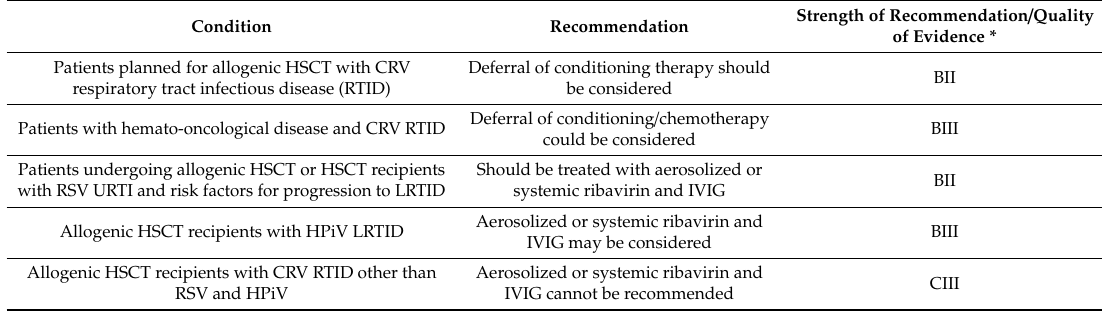
Table 5. ECIL-4 recommendations for the management of community-acquired respiratory infections in hematology patients [8].